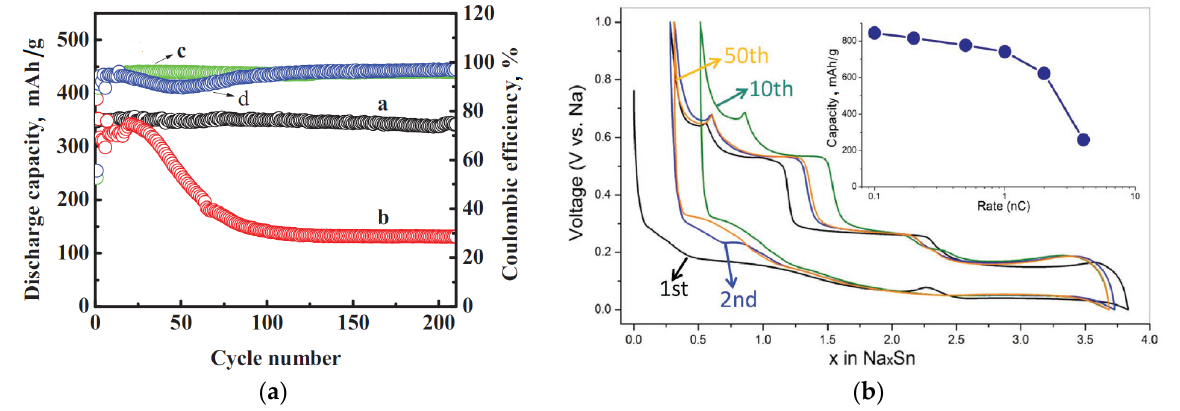
Figure 8. ( a ) Cycling performance (a, b) and Coulombic efficiency (c, d) at a cycling rate of 0.2 C in FEC-containing (a, c) and FEC-free (b, d) NaPF 6 /EC/DEC electrolytes NaPF 6 /EC/DEC electrolyte of porous CNF-SnSb electrodes. (Reprinted with permission from [151]. Copyright 2014, Wiley Online Library). ( b ) Performance of Sn electrode in 1 M NaPF 6 /DGME electrolyte: voltage profiles with their rate capability (inset), where 1 C equal to 847 mA/g. (Reprinted with permission from